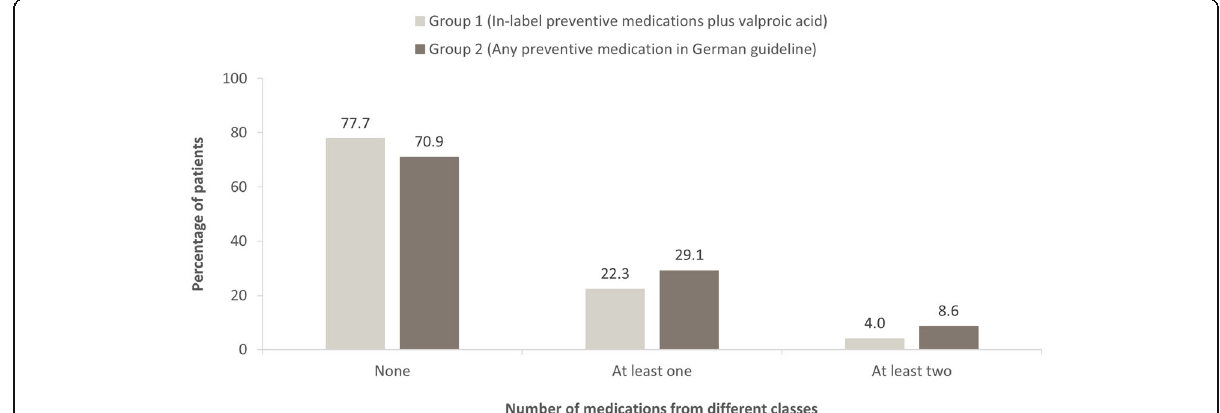
Fig. 6 Percentage of patients with no, at least one, or at least two prescriptions of preventive medications from different classes in the German Company Sickness Fund Database 2008 to 2016. Preventive medications considered were Group 1 (in-label preventive medications plus valproic acid, i.e. [metoprolol or propranolol], amitriptyline, flunarizine, topiramate, onabotulinum toxin A or valproic acid) and Group 2 (preventive medications according to German guideline for migraine [10]: Group 1 preventive medications plus opipramol, lisinopril or angiotensin II